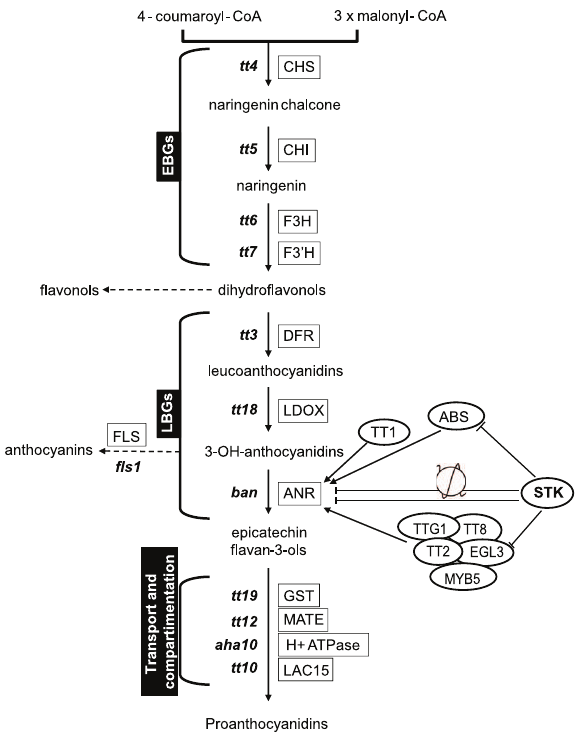
Fig. 4. STK has a pivotal role in the control of PA production. Schematic representation of the pathways for PA production. The genes involved in these pathways are shown in boxes. BAN , that was found to be up-regulated in RNA-Seq, has been analysed by in situ hybridization, qRT-PCR and ChIP assay. The ChIP assay demonstrated that STK directly regulates BAN , ABS and EGL3 (solid line). The ChIP assay revealed that STK function negatively correlates with the level of the H3K9ac mark on the BAN promoter (solid line with